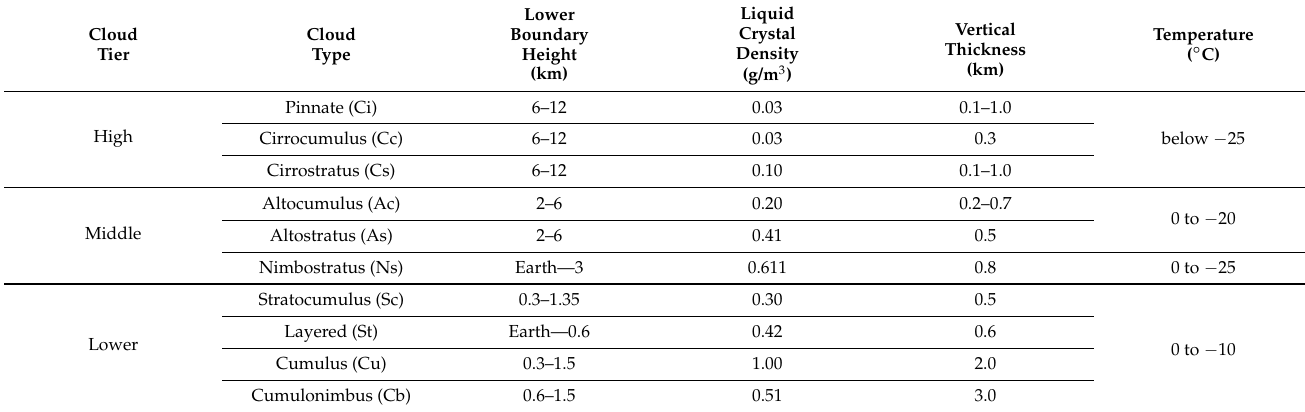
Table 2. Cloud classification in different Earth regions